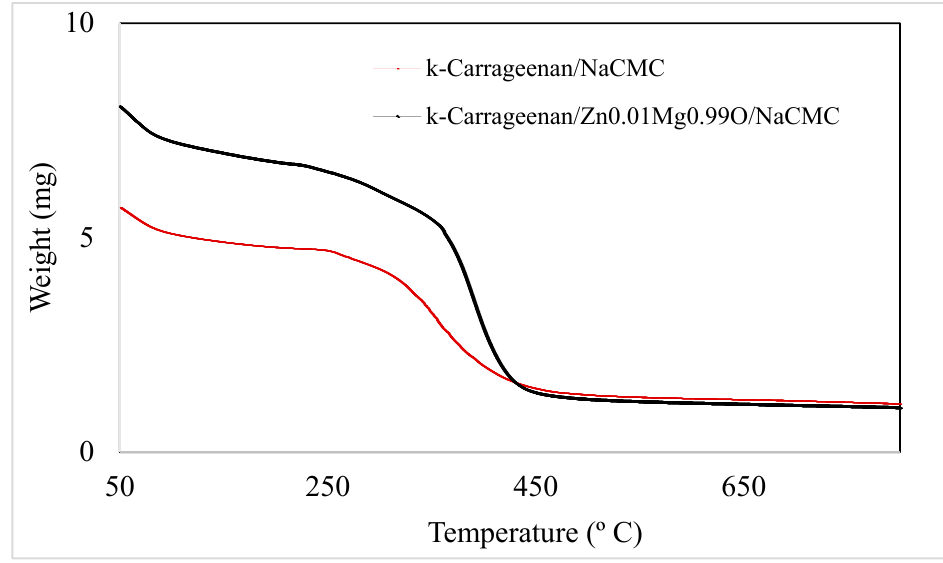
Figure 8. TGA curves of κ -Carrageenan/ Mg 0.99 Zn 0.01 O /NaCMC and of κ -Carrageenan/ NaCMC .